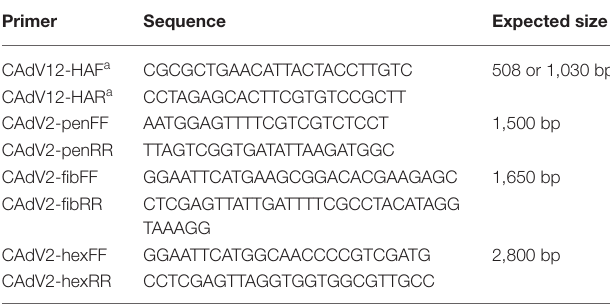
TABLE 1 | Primers and expected amplicons sizes for detection and